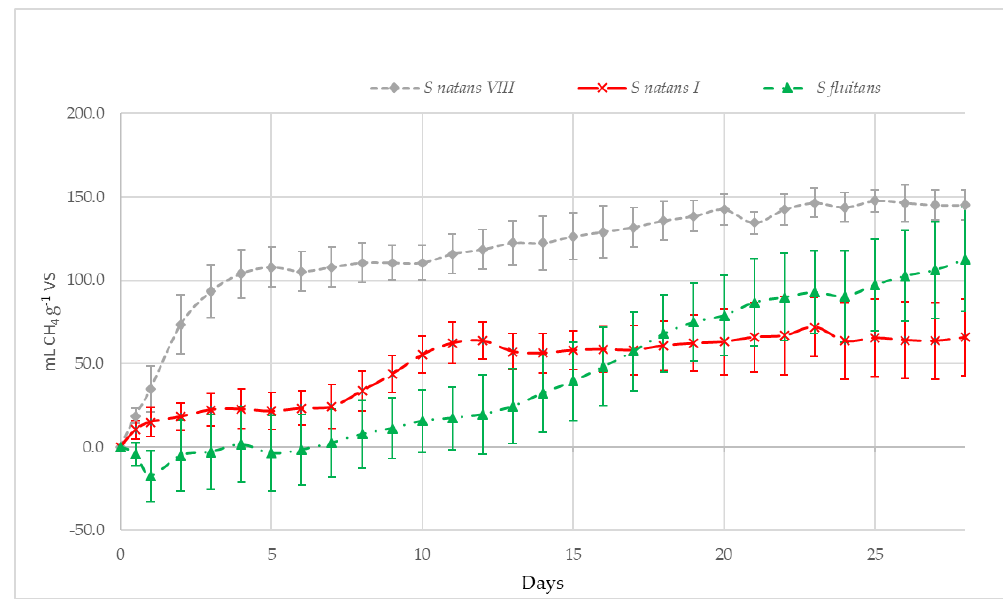
Figure 5. Net mean methane production from the three pelagic Sargassum species samples from Turks and Caicos ( n = 4, error bars are standard deviation).